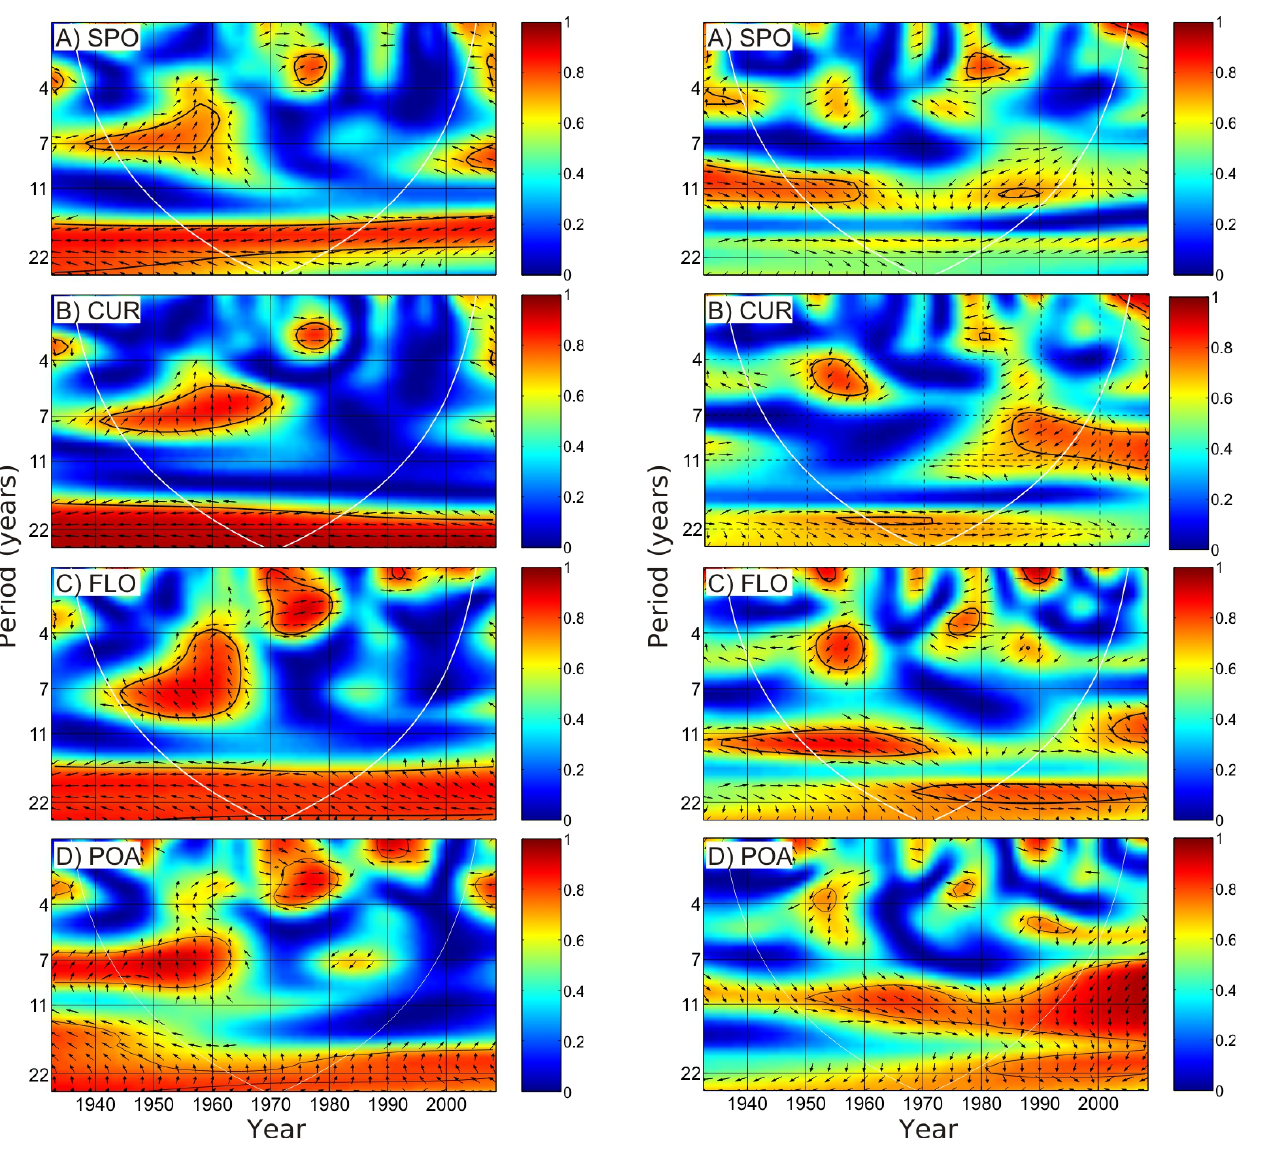
Fig. 5. Wavelet coherence spectrum between temperature data and the Rz22 time series computed for SPO (A) , CUR (B) , FLO (C) , and POA (D) . Coherence values are indicted by colors. The white line indicates the COI, below which edge effects may be important. The black lines are the limit of the 95% confidence level for red noise. Black arrows represent the phase angle between two investigated time series.